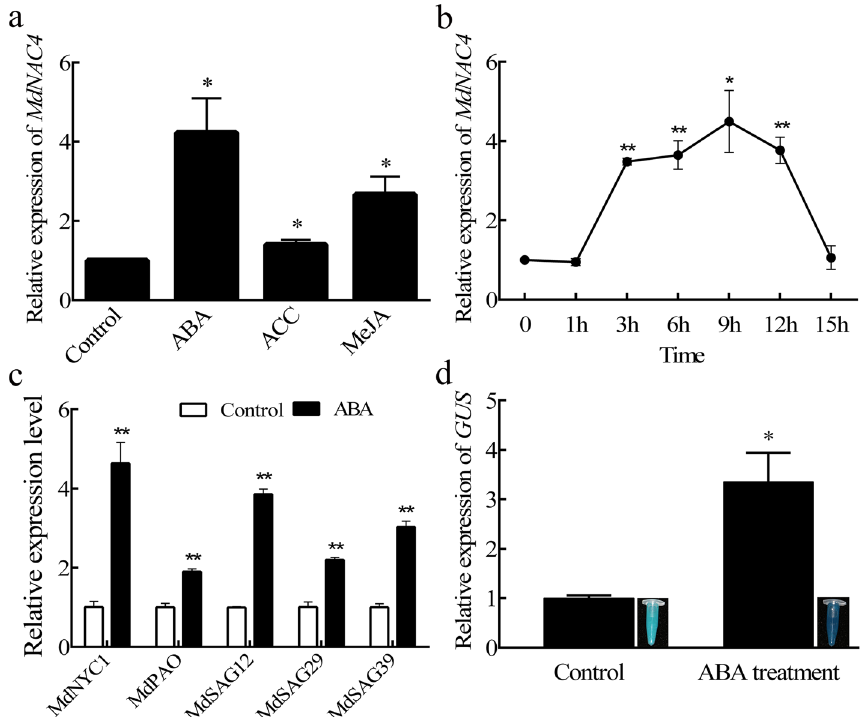
Fig. 1 Response of MdNAC4 to ABA treatment. a Expression levels of MdNAC4 in apple seedling leaves treated with different phytohormones. Apple seedlings grown in the nutrient bowl were treated with 50 μM abscisic acid (ABA), 50 μM methyl jasmonate (MeJA), and 50 μM 1-aminoc yclopropane-1-carboxylic acid (ACC) for 9 h by adding solutions containing ABA, ACC, and MEJA to the nutrient bowl. b Expression patterns of MdNAC4 after 50 μM ABA treatment. Samples were taken at designated times (0, 1, 3, 6, 9, 12 and 15 h) for RNA extraction. c Expression levels of senescence-related genes ( MdNYC1 , MdPAO , MdSAG12 , MdSAG29 and MdSAG39 ) after 50 μM ABA treatment for 9 h. (d) GUS staining and qRT–PCR analysis of MdNAC4 promoter transgenic apple calli. Control: no treatment; ABA treatment: 50 μM ABA treatment for 9 h. The expression level in untreated samples was set at 1. Error bars indicate the SDs of the three technical replicates and three biological replicates. Asterisks indicate significant differences between two independent samples according to t tests (*, P < 0.05 and **, P <